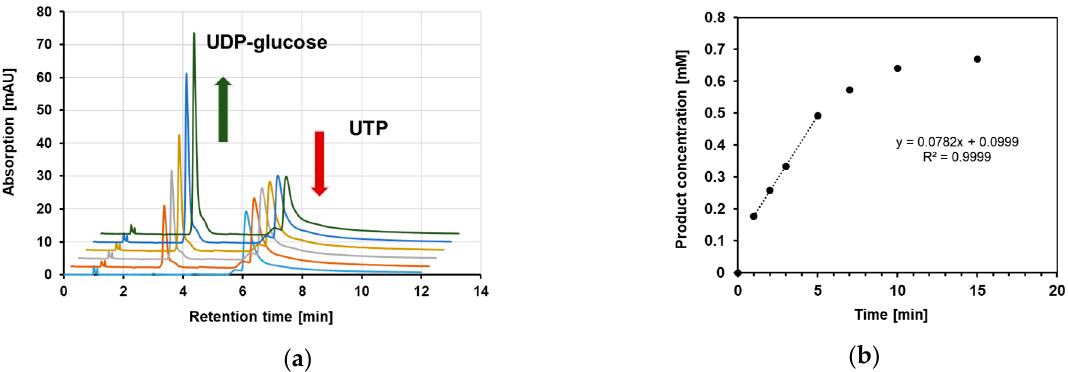
Figure 5. Enzymatic conversion of UTP and glucose 1-phosphate into UDP-glucose and PP i . In ( a ) the HPLC chromatograms of a time course from 0 to 7 min are presented and the determined concentration of UDP-glucose was used to calculate a product formation rate as shown in ( b ). For this analysis the standard enzyme assay and determination methods as described in materials and methods section have been used.